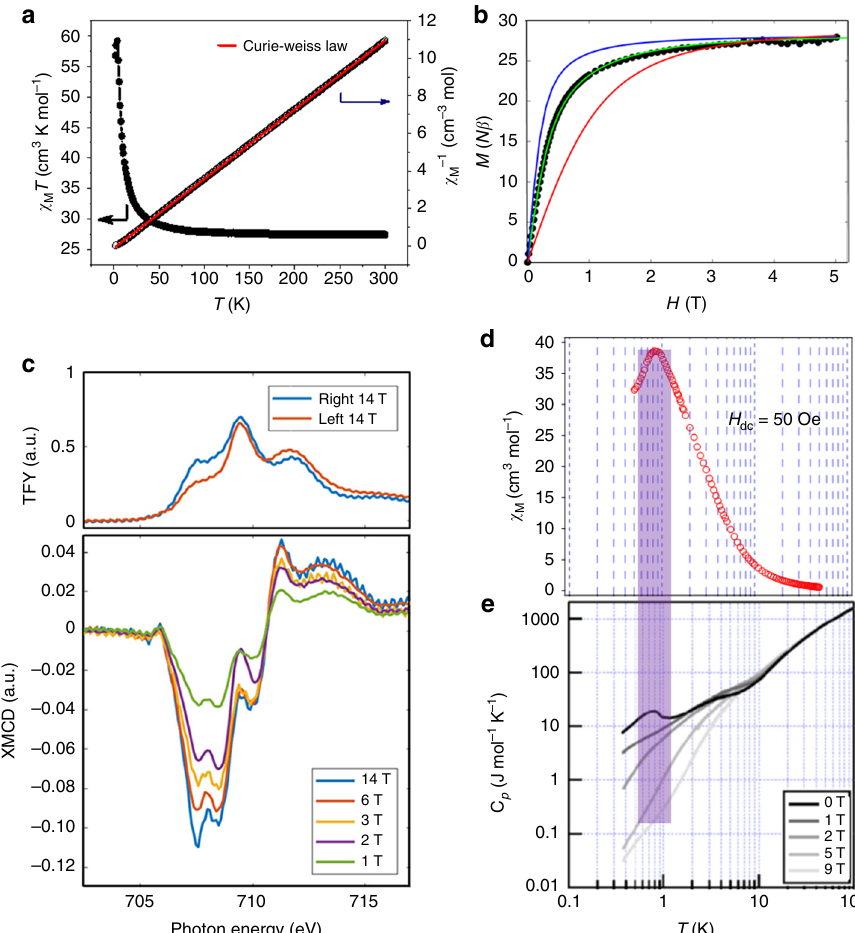
Fig. 4 Magnetic characterization. a Temperature dependence of χ M T and χ M − 1 for [Fe 14 ] ( H dc = 100 Oe). The black symbol is the experimental data and the red line is the fi tting result. b Magnetization vs. external magnetic fi eld curve for [Fe 14 ] at 2 K. The blue line corresponds to the calculated Brillouin function for S = 14 ( J → + ∞ ). The red line represents the sum of the Brillouin functions that correspond to four magnetically isolated S = 5/2 and two S = 2 ( J = 0). The green line represents the simulated curve that includes weak ferromagnetic coupling between B sites ( J = 0.9 K, g = 2.0). c Top: the left and right circularly polarized L 3 -edge total fl uorescence yield spectra of the [Fe 14 ] complex (14 T, 3.5 K). Bottom: the fi eld dependence of the [Fe 14 ] L 3 -edge XMCD spectra (left – right) measured at 3.5 K. d Magnetic susceptibility under a 50 Oe fi eld in the temperature region of 50 – 0.5 K. e The fi eld-dependent heat capacity of [Fe 14 ] from 0 to 9 T in the temperature region of 100 – 0.36